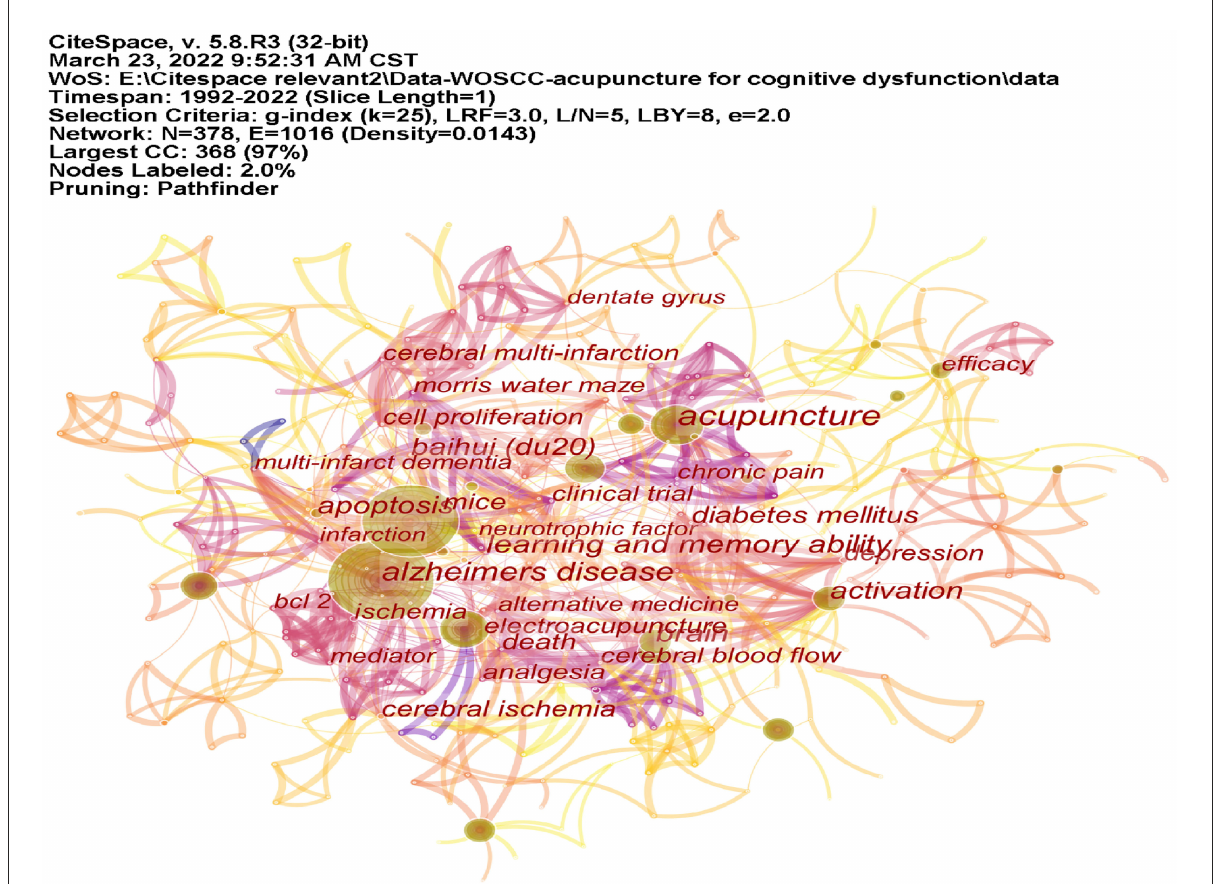
FIGURE10 The co-occurrence map of keywords. CiteSpace was used to analyze the co-occurrence of keywords. The figure shows that the keywords, such as Alzheimer’s disease (AD), acupuncture, electroacupuncture, brain, activation, and Baihui occupied the main position.